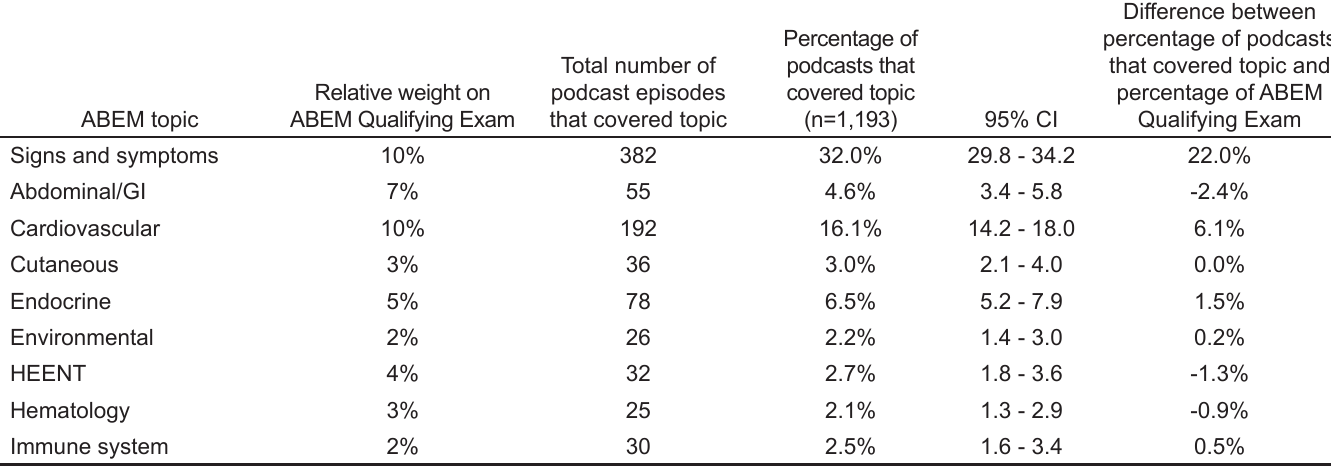
Table 2. Proportional representation of individual podcast episodes that covered ABEM EM Model topics relative to the ABEM Qualifying